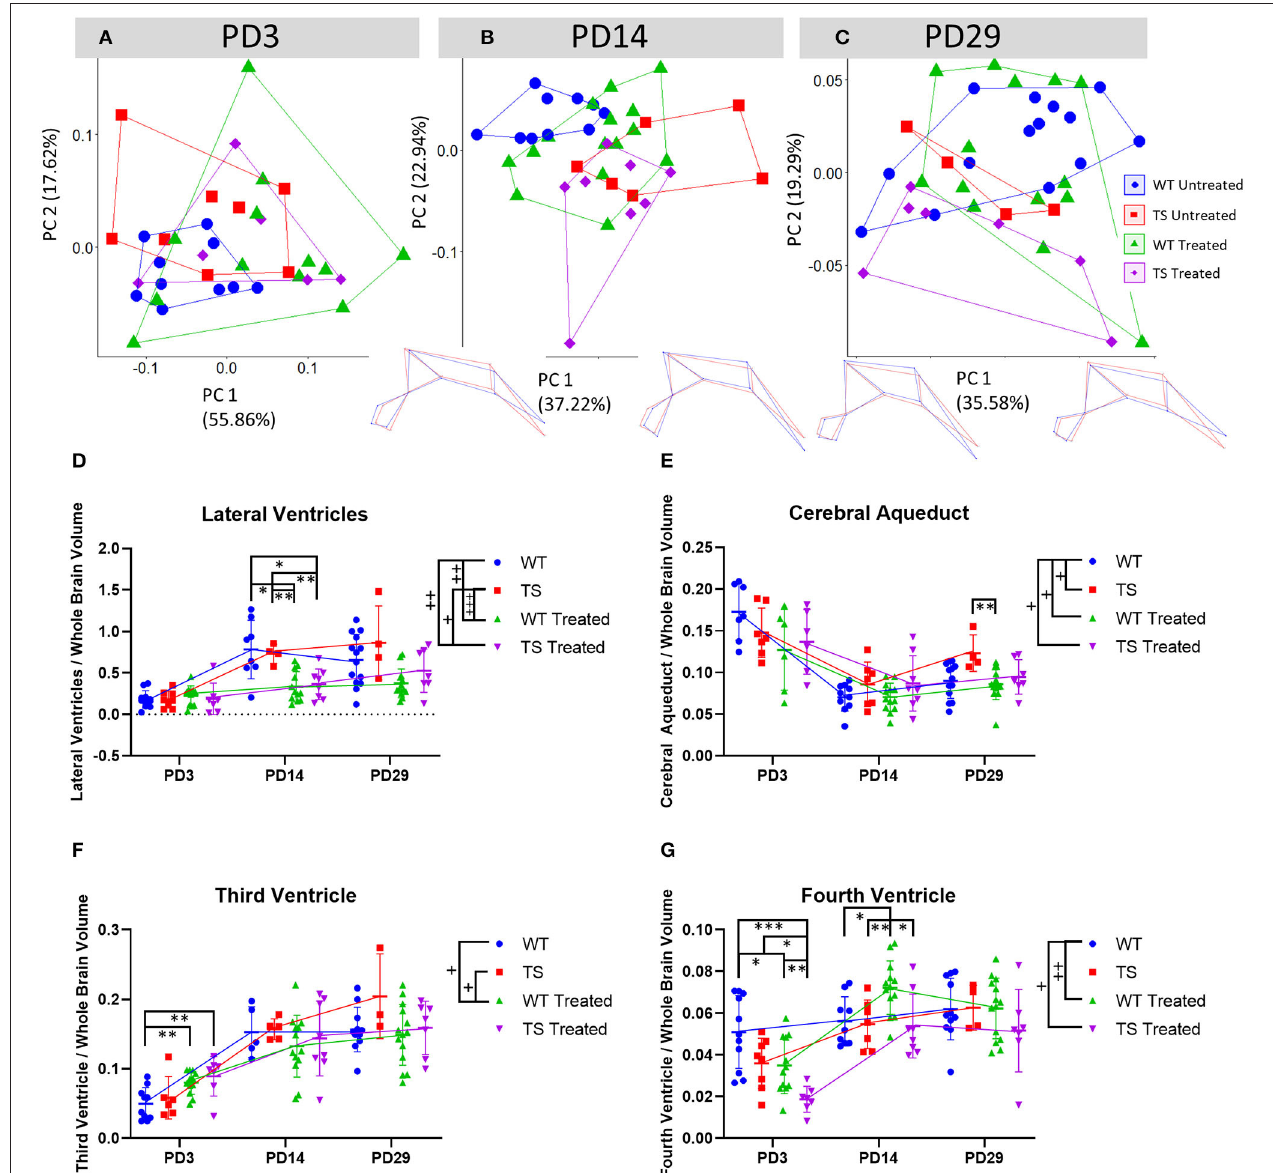
FIGURE 3 | Postnatal ventricular alterations in Ts65Dn mice and modulatory effects of perinatal GTE-EGCG treatment. (A–C) Ventricular shape variation assessed by a Principal Component Analysis (PCA) based on the landmarks registered on the sagittal plane of in vivo µ MRI scans as described in Supplementary Table S4 at (A) PD3, (B) PD14, and (C) PD29. PCA are presented along with the wireframes displaying ventricular morphologies along PC1. Dark blue wireframes represent the morphology associated with the specimens located on the negative or positive extreme of PC1 (shape changes associated with PC scores of 0.1 and − 0.1) in comparison to the mean shape of the sample (red wireframe) to better illustrate the differences in shape. Ratios of the volumes of (D) the lateral ventricles, (E) the cerebral aqueduct, (F) the third ventricle and (G) the fourth ventricle normalized by the total brain volume at postnatal days (PD) 3, 14, and 29, estimated from in vivo µ MRI scans. Data are presented as mean ± standard deviation. + p < 0.05; ++ p < 0.01; +++ p < 0.001; Mixed-effects analysis across timepoints; * p < 0.05; ** p < 0.01; *** p < 0.001; Mann Whitney tests by timepoint. Sample size: (PD3) WT = 11 (10 third ventricle and ventricular shape, seven cerebral aqueduct), TS = 8 (seven cerebral aqueduct, six third ventricle), WT Treated = 12 (11 lateral ventricles, six cerebral aqueduct), TS Treated = 7 (six cerebral aqueduct and ventricular shape); (PD14) WT = 10 (nine fourth ventricle, eight lateral ventricles, five third ventricle), TS = 7 (six ventricular shape, five third ventricle, four lateral ventricles), WT Treated = 13 (15 ventricular shape, 12 lateral ventricles), TS Treated = 8; (PD29) WT = 14 (13 cerebral aqueduct, 11 third ventricle and fourth ventricle), TS = 4 (three third ventricle), WT Treated = 14 (13 lateral ventricles), TS Treated =